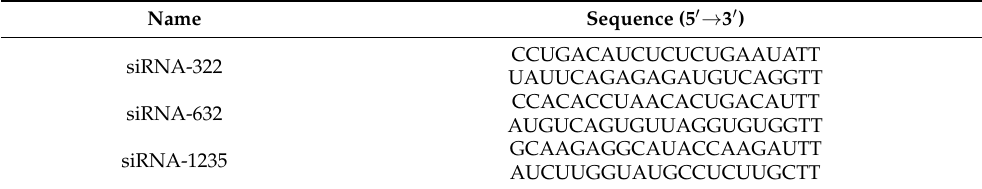
Table 1. The sequence information of siRNA-BMP4.